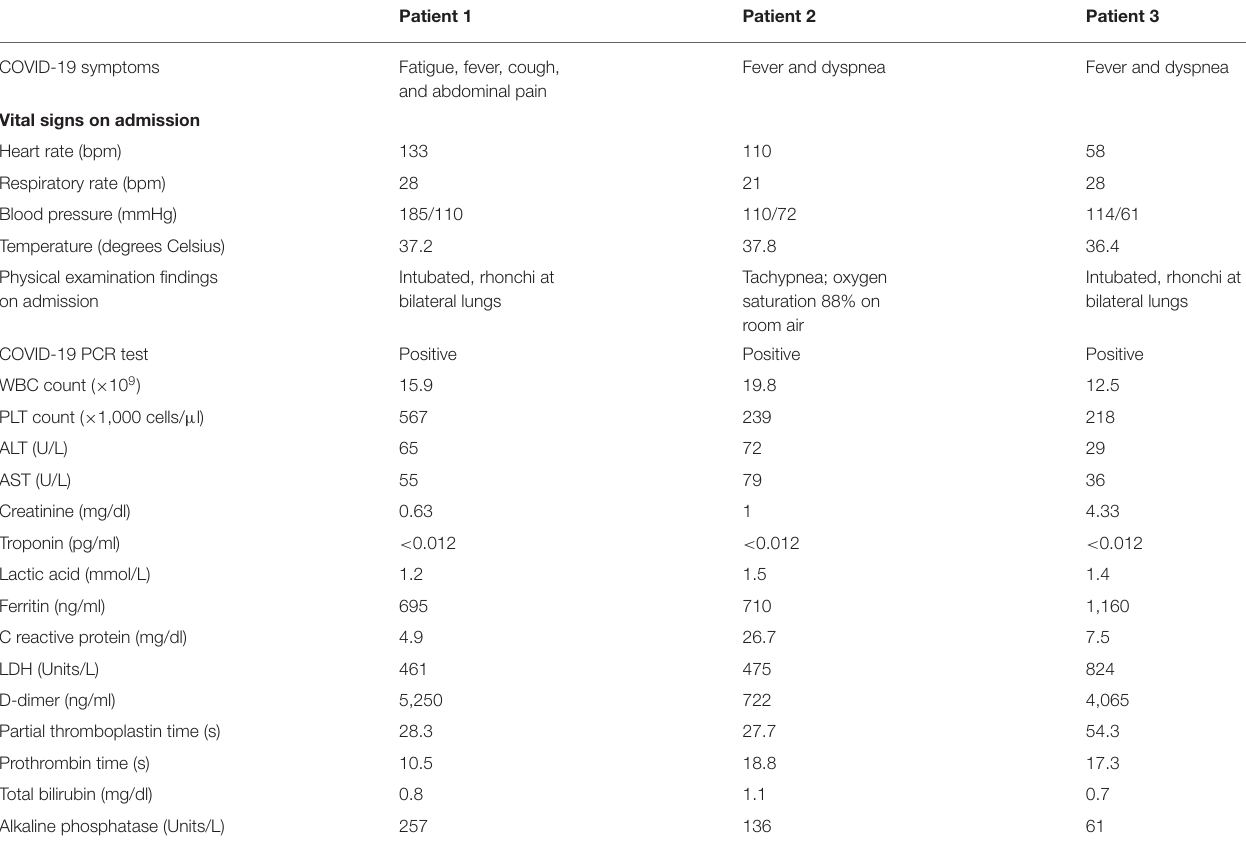
TABLE 2 | Clinical presentations and baseline laboratory studies on